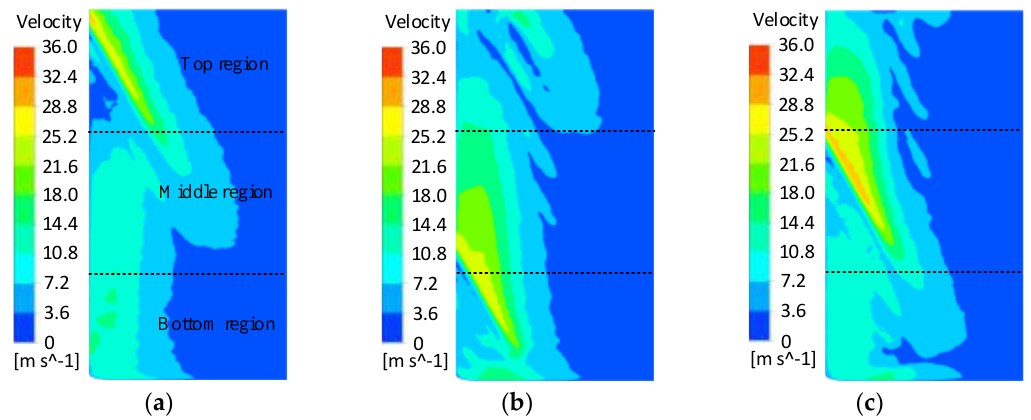
Figure 4. Electrolyte velocity distribution in the side gap when using tool B at different angles: ( a ) 30°, ( b ) 60°, ( c ) 90°.